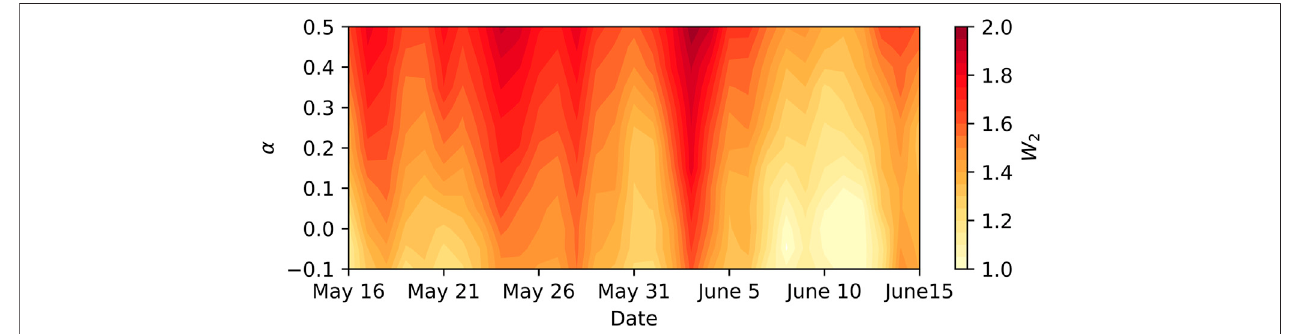
FIGURE 5 | W 2 for the 31 days between MERRA-2 AOD and G5NR AOD including a bias adjustment, α . α ranges from − 0.1 to